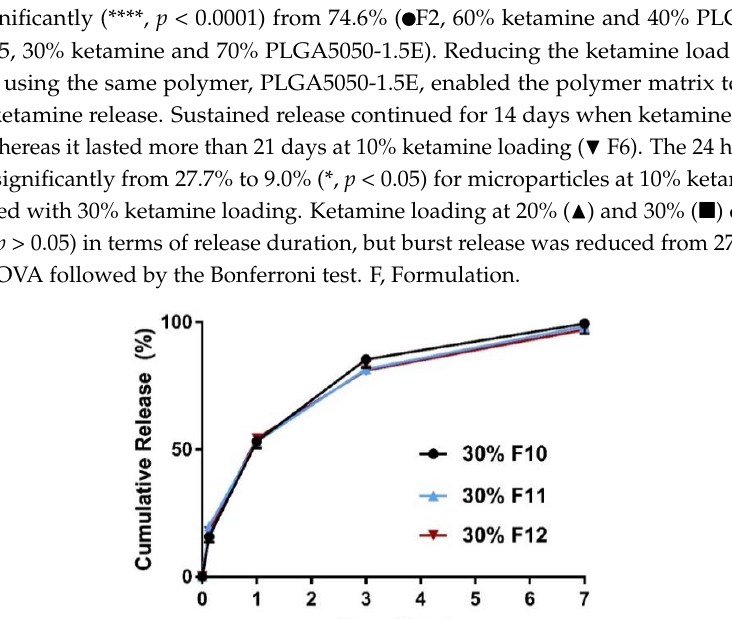
Figure 3. Mean ( ± SEM) in vitro ketamine release profiles did not differ significantly ( p > 0.05) between the three acid end-capped polymers assessed ( n = 3). A maximum of one-week sustained release was achieved in vitro. The cumulative release in 24 h was ~55%, >80% in three days, and 100% in one week for formulations 10–12, respectively. F, Formulation; F10, PLGA5050-1A (50%) and PLGA7525-4A (20%); F11, PLGA5050-2A (70%); F12, PLGA5050-1A (70%).